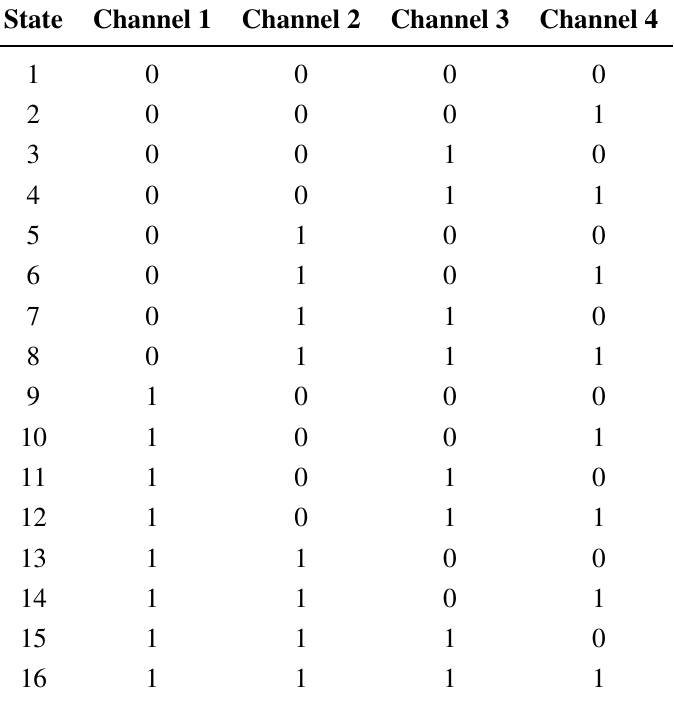
Table 2. 16 possible liquid metal injecting states of the proposed SIW